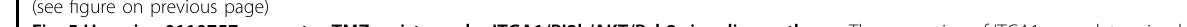
Fig. 5 Hsa_circ_0110757 promotes TMZ resistance by ITGA1/PI3k/AKT/Bcl-2 signaling pathway. The expression of ITGA1 were determined by RT-qPCR. A Control vectors or inhibitors were cotransfected in U87/R cells. B U87 cells were cotransfected with control vectors and miR-1298-5p. C IC50 of TMZ was detected in U87/R cells transfected with the indicated vectors with TMZ application. D The apoptosis rates of U87/R cells with different transfection. E Live/dead cell staining of U87 cells with indicated transfection. Live cells were stained with green fl uorescent, and dead cells were stained with red fl uorescent. F The expression levels of ITGA1, PI3K/AKT, and antiapoptotic protein Bcl-2 were detected by western blotting in U87/R cells transfected with si-ITGA1. The expression levels of ITGA1, PI3K/AKT, and antiapoptotic protein Bcl-2 were detected by western blotting in U87/R cells transfected with indicated vectors alone or cotransfected with the inhibitor ( G ), in U87 cells transfected with the indicated vectors and miR-1298-5p ( H ) and in U87 cells transfected with the indicated vectors and 3-MA ( I ). ** P <